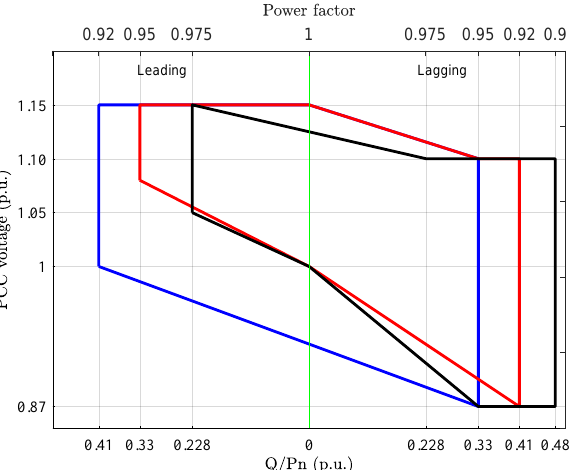
Figure 11. Basic requirements regarding the supply of reactive energy from renewable plants in Germany. The choice of the 3 regions should be made by the TSO.